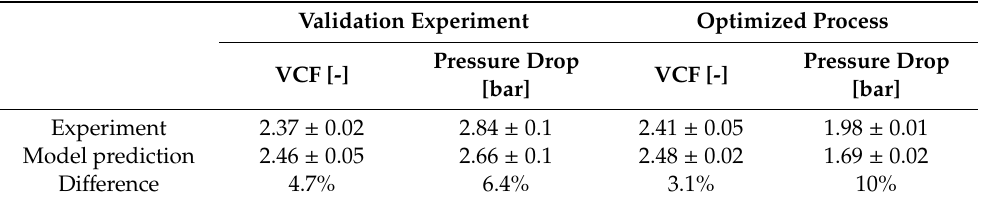
Table 5. Comparison of experimental and simulated process variables for SPTFF kit.